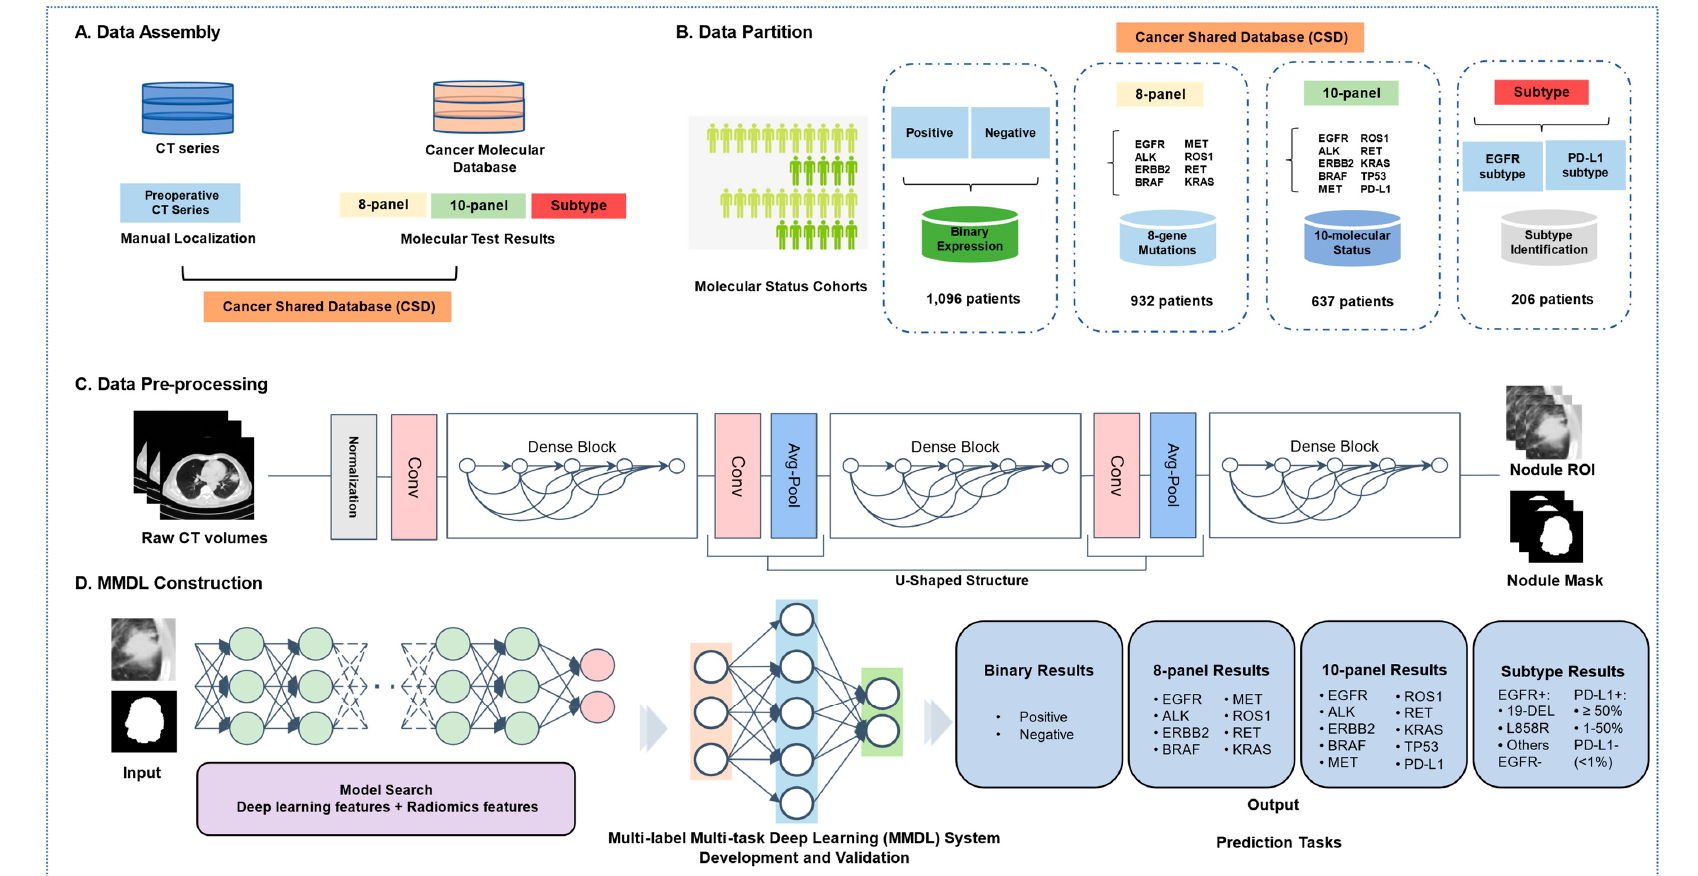
Figure 1. Overall workflow of the MMDL system. ( A ) Data assembly included the original CT image data, molecular status, subtypes, and clinical records. ( B ) Data partition: for model development and validation, the acquired data set was further partitioned into target binary expression (positive expression of at least one molecule and all negative molecular expression ), multiple molecular status prediction tasks (8-panel or 10-panel), and subtype prediction tasks (19-DEL, L858R, other mutation and wild type for EGFR ; TPS cut-off of 50%: low PD-L1+ and high PD-L1+ for PD-L1 positive expression, and PD-L1- represents the negative expression of PD-L1). ( C ) The DenseNet backbone-based U-Shaped deep learning segmentation architecture performed tumor mask annotation. ( D ) A novel MMDL hybrid architecture fused the extracted radiomics features and deep learning features for our multi-task